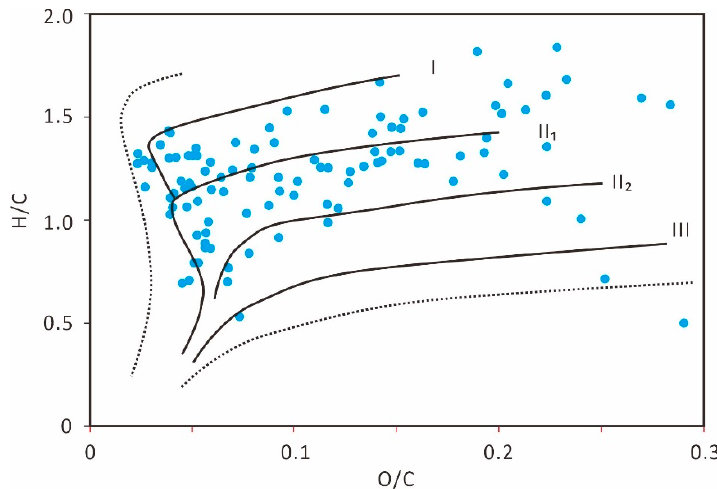
Figure 4. Kerogen types of source rocks of the Permian Fengcheng